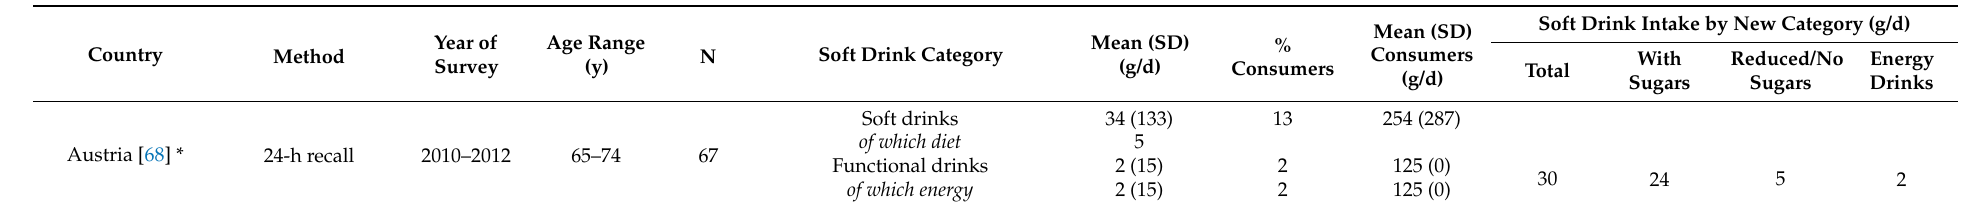
Table 6. Soft drink intake in older adults(~>65 y) in the WHO European Region, as reported in National Dietary Surveys and by new